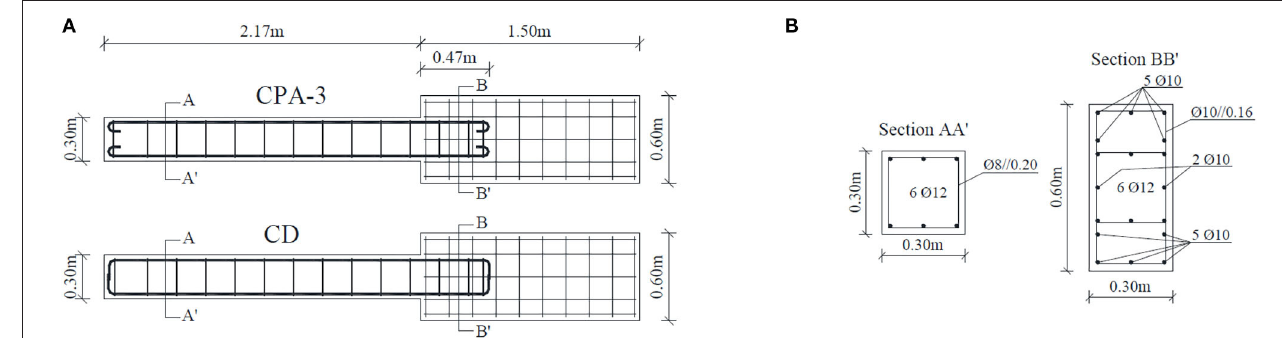
FIGURE 1 | Column specimens: (A) dimensions and reinforcement detailing; (B)